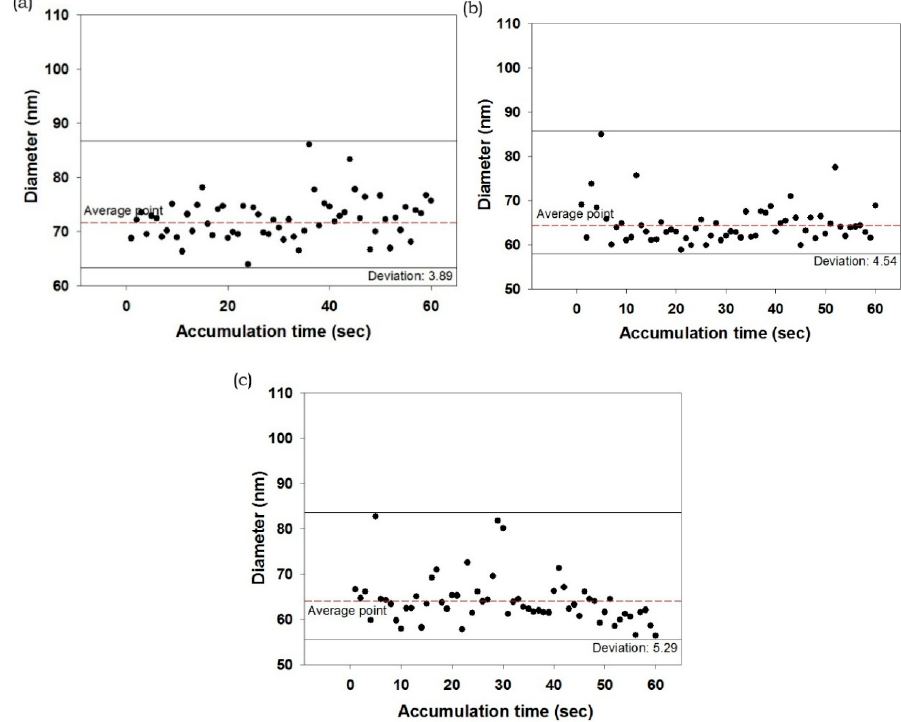
Figure 8. Results of particle size analysis during high-pressure dispersion at 1587 × 10 5 Pa. Diameter distributions after ( a ) one dispersion pass as a function of time, ( b ) two dispersion passes as a function of time, and ( c ) three dispersion passes as a function of time.